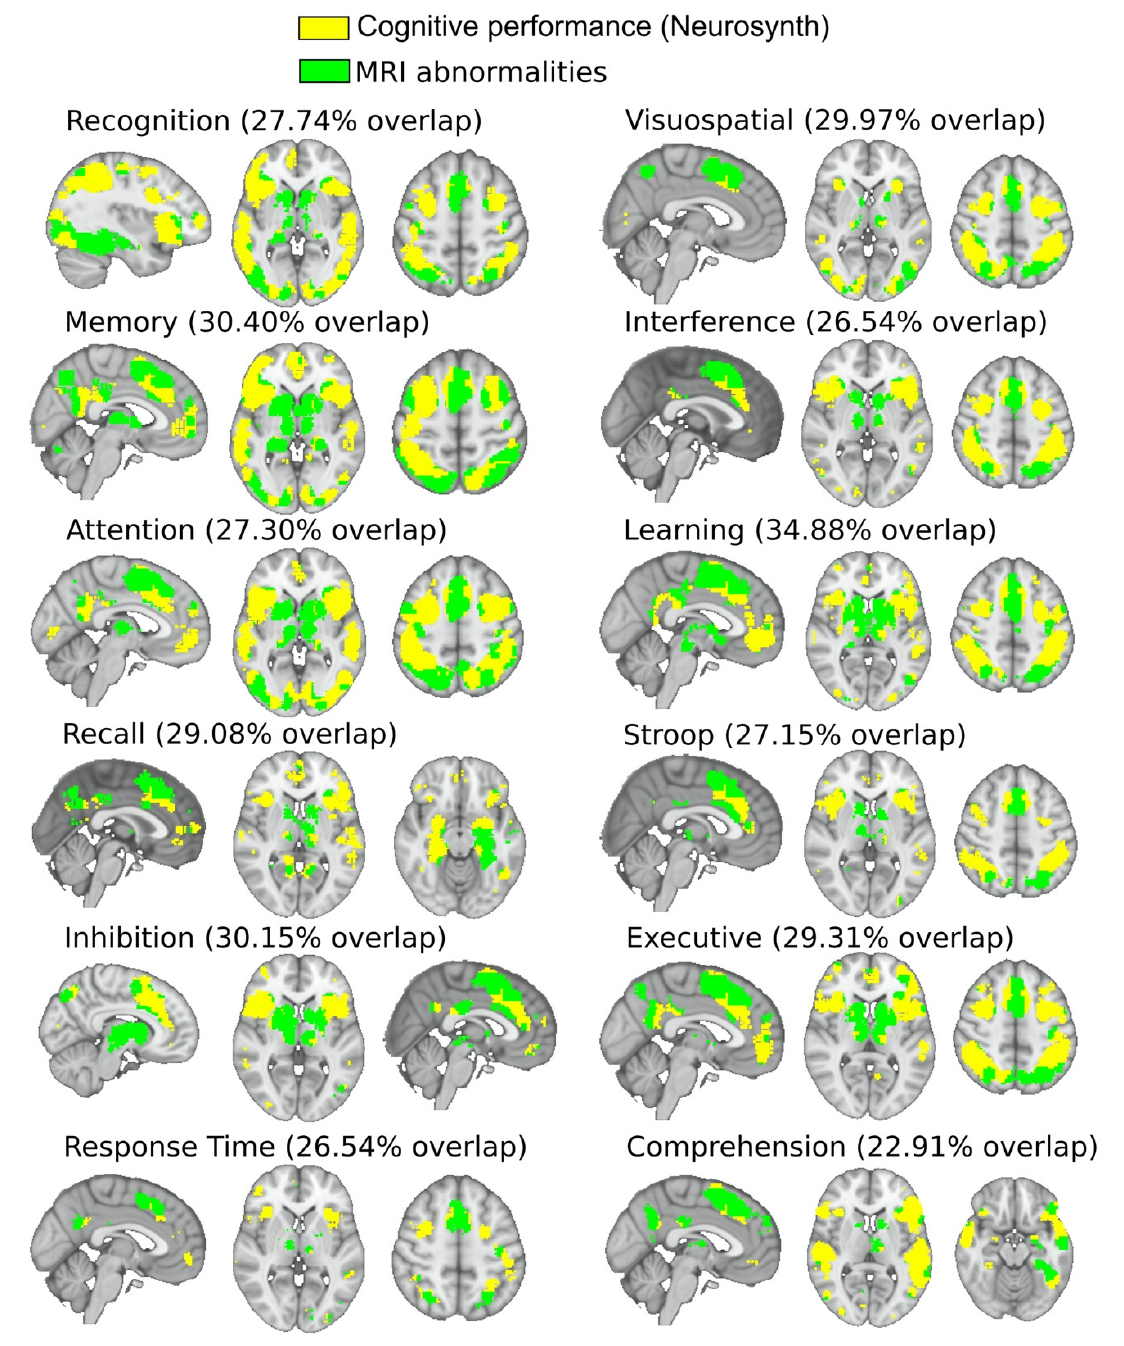
Figure 4. Correspondence between brain MRI alterations and cognitive performance in combined Cobalamin D disorder. By pooling together the brain maps proceeding from the three classes of imaging alterations represented in Figure 3 (colored in green), we illustrate their overlapping with cognitive maps (yellow color) obtained from Neurosynth co-activation